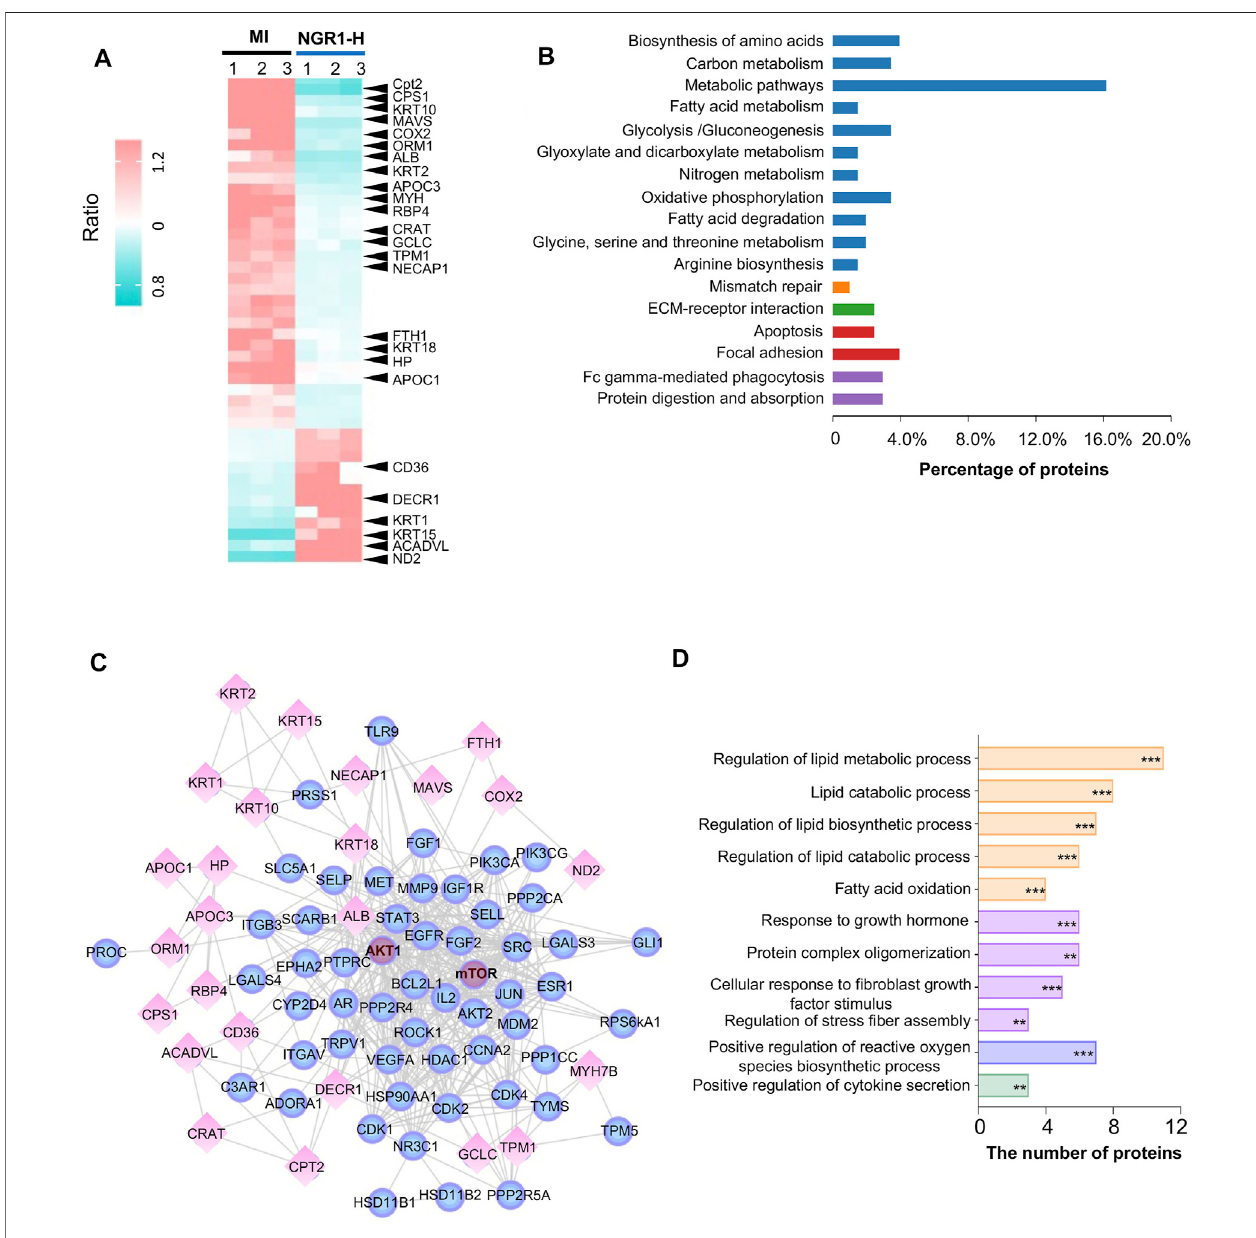
FIGURE 5 | Myocardial proteomics combined with network pharmacology revealed that NGR1 improved lipid metabolism in the ischemic myocardium. (A) Heatmap of differential proteins between the NGR1-H group and the MI group. (B) Functional annotation of differential proteins. (C) Lipid metabolism – associated network including reverse-docked targets and differential proteins. Spheres represent reverse-docked targets and diamonds represent differential proteins. (D) Functional annotation of proteins in the lipid metabolism – associated network. These proteins in the lipid metabolism – associated network were annotated by GO terms. The pathways were evaluated by a false-positive rate, * F < 0.05, ** F < 0.01, and *** F < 0.001.